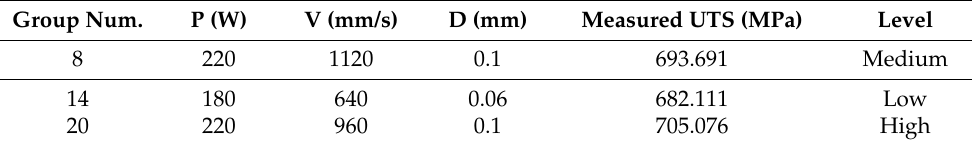
Table 5. Selected groups of specimens for fracture